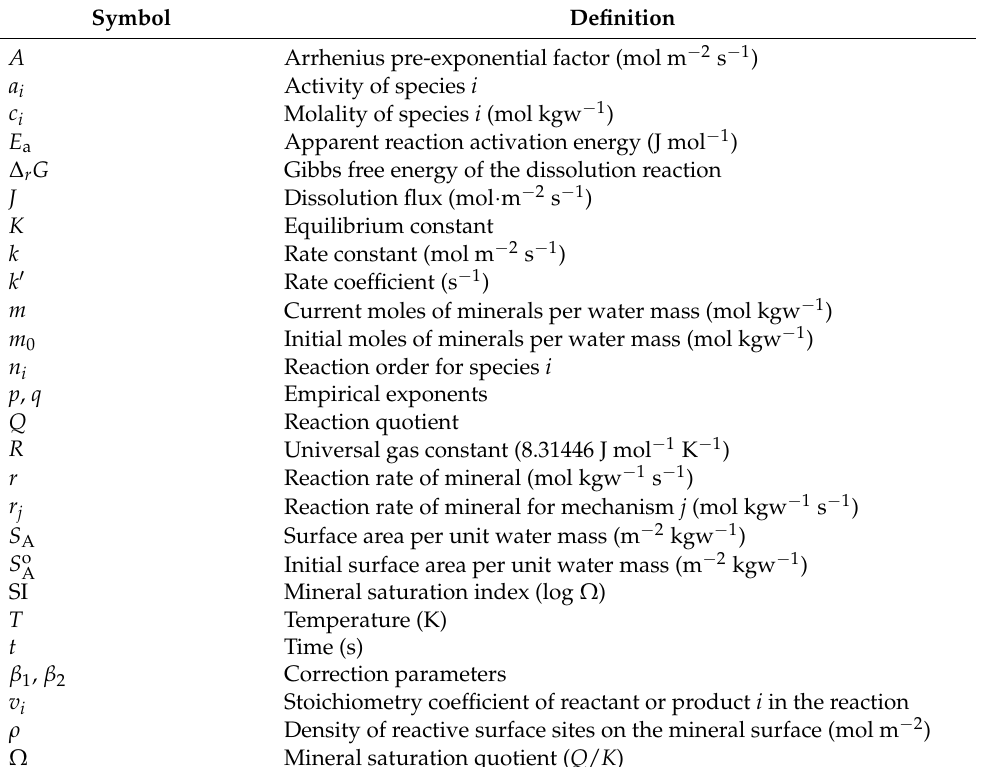
Table 2. List of symbols and definitions.